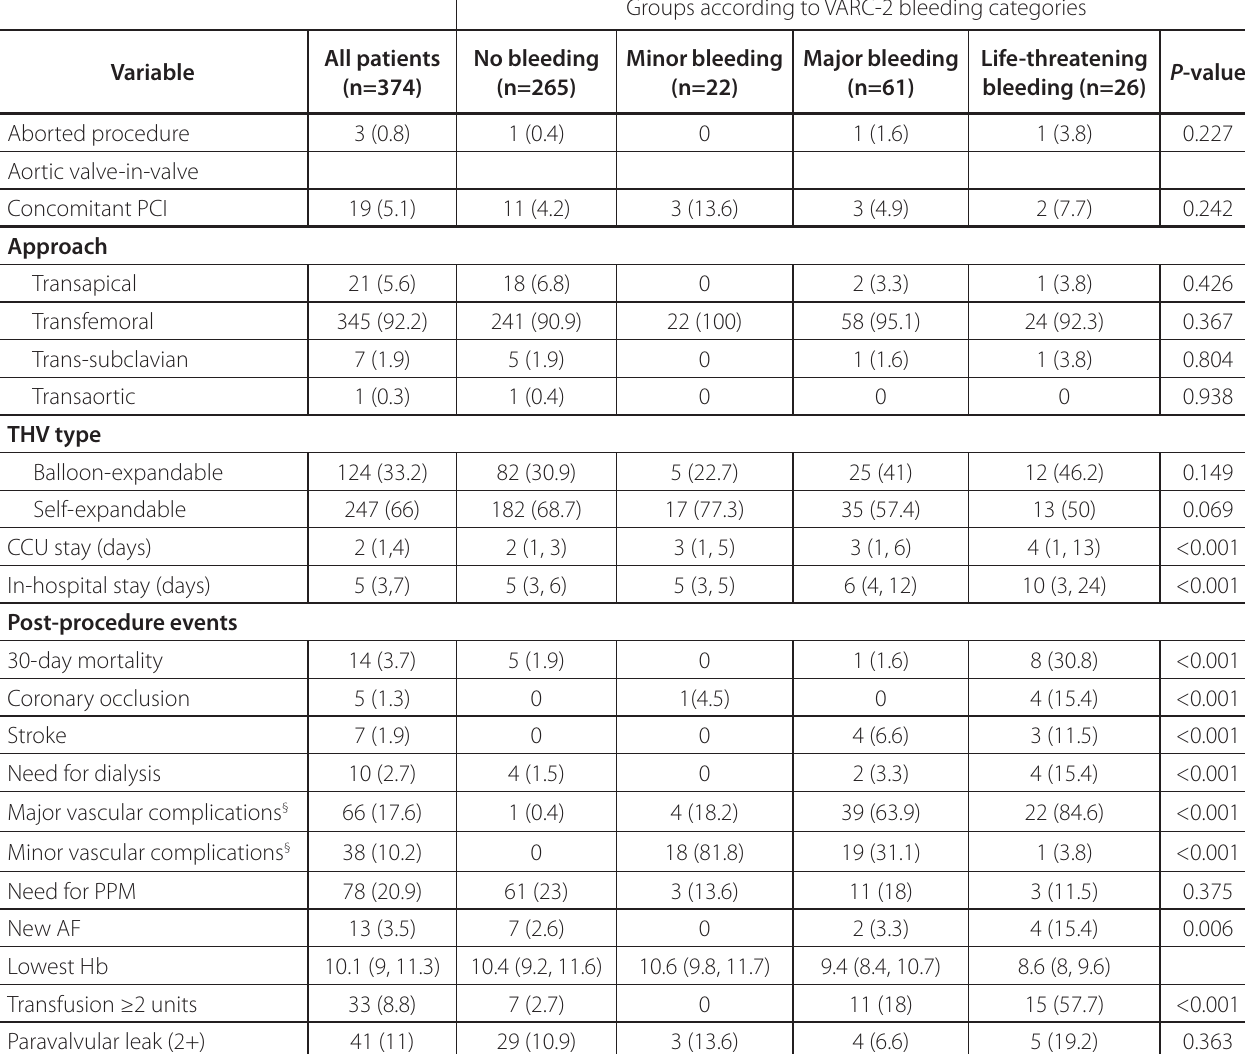
Table 2 . Operative and post-procedure characteristics and events.